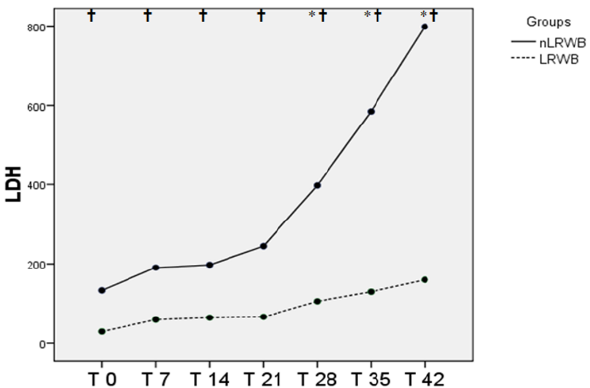
Figure 5. Differences in LDH (mean) measured in nLRWB and LRWB units during the storage period. The days of storage are presented in the x-axis. LDH (U/L) is presented in the y-axis. Asterisks * p < 0.05.